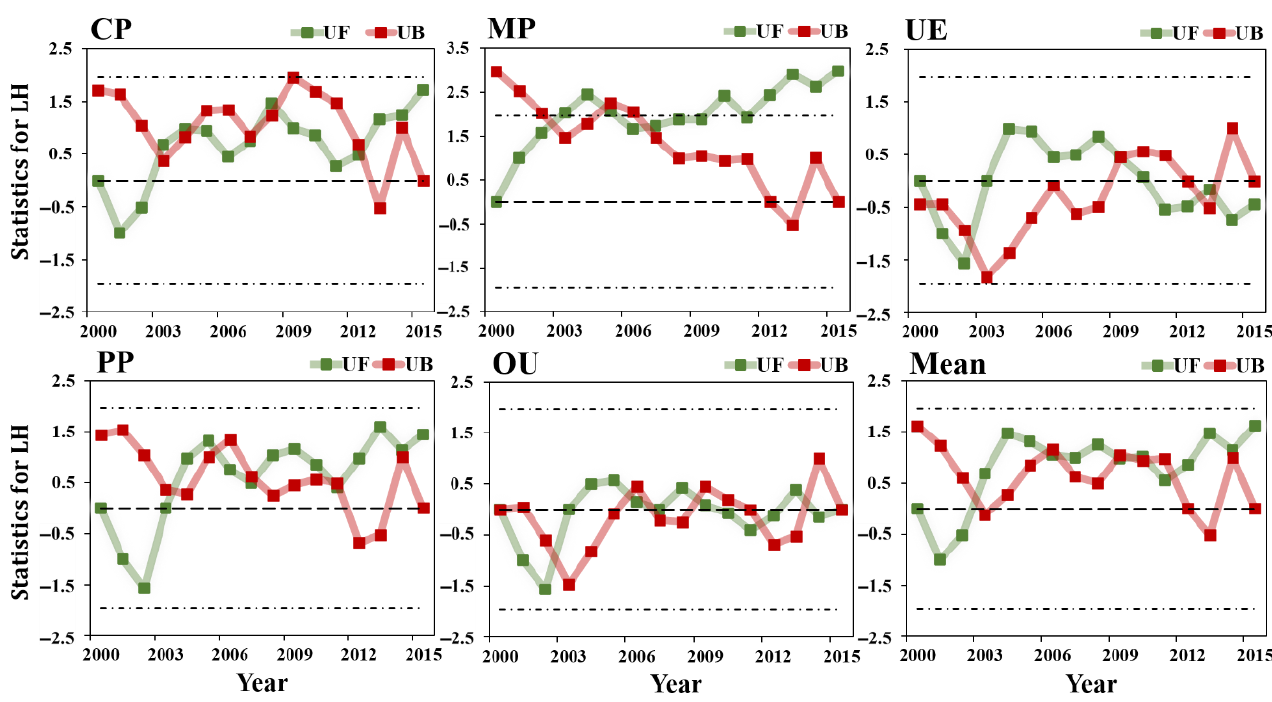
Figure 11. Mann-Kendall test of latent heat flux (LH) for different land use types in the Huang-Huai-Hai River Basin from 2000 to 2015.